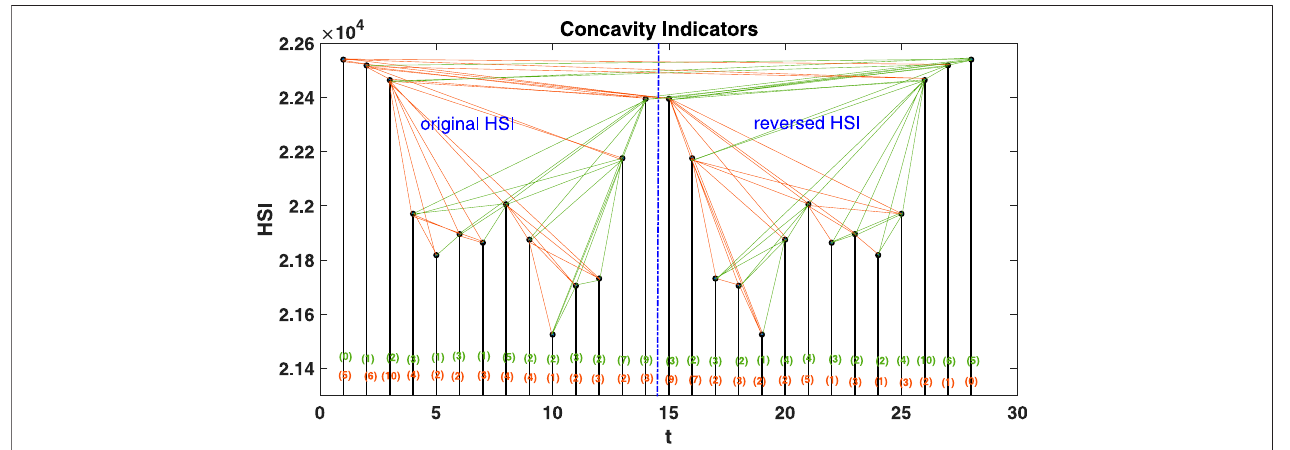
FIGURE 1 | Application of VGA to the daily Hang Seng Index from August 13, 2013, to September 2, 2013, and its time-reversely mirrored data set. Note that the perfect re fl ection symmetry between AR [nodes 10 – 14] and DF [nodes 1 – 5] is demonstrated via identically distributed degrees in the two networks.